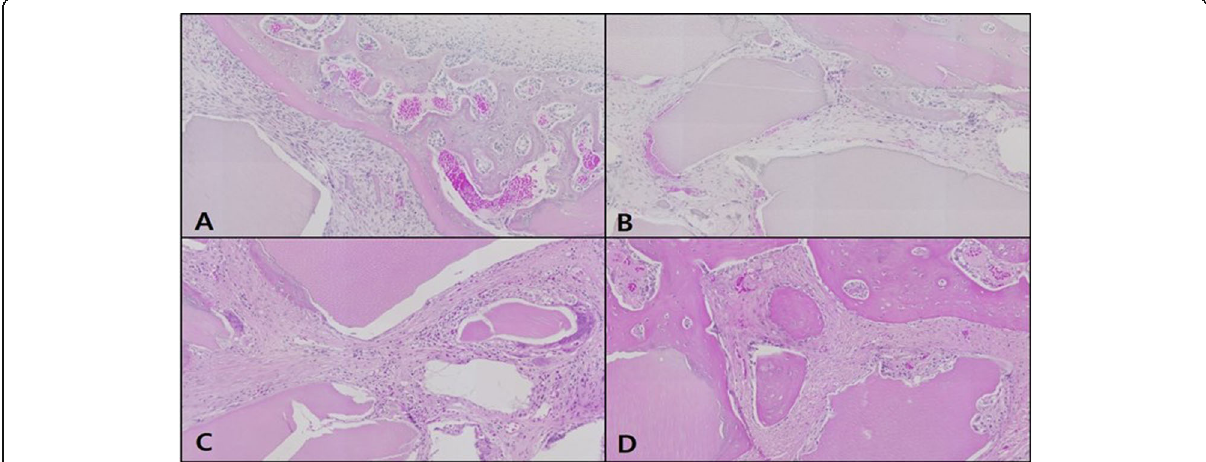
Fig. 9 Microphotograph at 1 week ( A ), 2 weeks ( B ), 4 weeks ( C ), and 6 weeks ( D ) after bone graft with organic matter removed particulate autogenous tooth and type 1 collagen in experimental rabbit. H-E. ×50